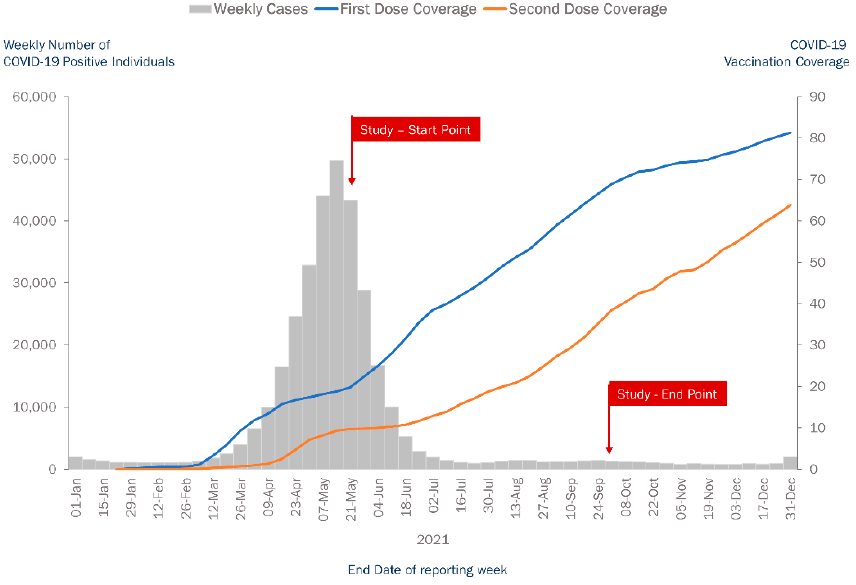
Figure 1. Vaccine coverage among the eligible population (18+) and the total number of reported